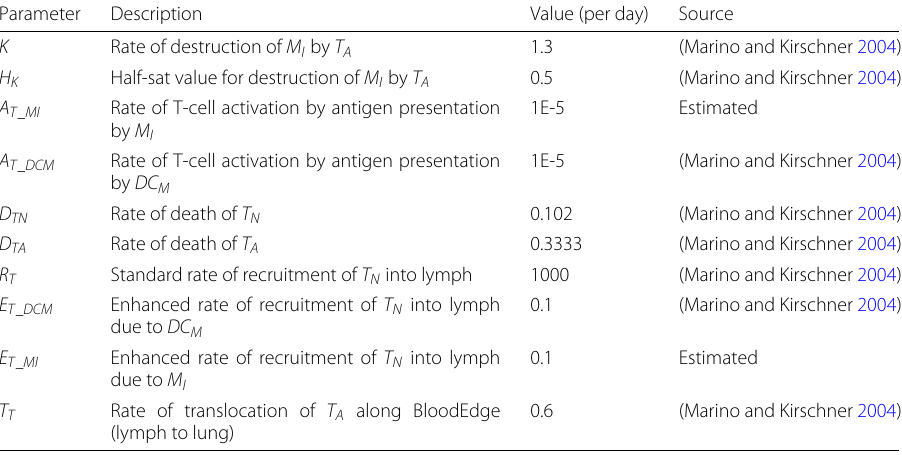
Table 6 T-cell event parameters used for experiments, unless specified in the text Parameter Description Value (per day) Source K Rate of destruction of M I by T A 1.3 (Marino and Kirschner 2004) H K Half-sat value for destruction of M I by T A 0.5 (Marino and Kirschner 2004) 1E-5 Estimated A T _ MI Rate of T-cell activation by antigen presentation by M I 1E-5 (Marino and Kirschner 2004) A T _ DCM Rate of T-cell activation by antigen presentation by DC M D TN Rate of death of T N 0.102 (Marino and Kirschner 2004) D TA Rate of death of T A 0.3333 (Marino and Kirschner 2004) R T Standard rate of recruitment of T N into lymph 1000 (Marino and Kirschner 2004) 0.1 (Marino and Kirschner 2004) E T _ DCM Enhanced rate of recruitment of T N into lymph due to DC M 0.1 Estimated E T _ MI Enhanced rate of recruitment of T N into lymph due to M I 0.6 (Marino and Kirschner 2004) T T Rate of translocation of T A along BloodEdge (lymph to lung) Bacterial translocation